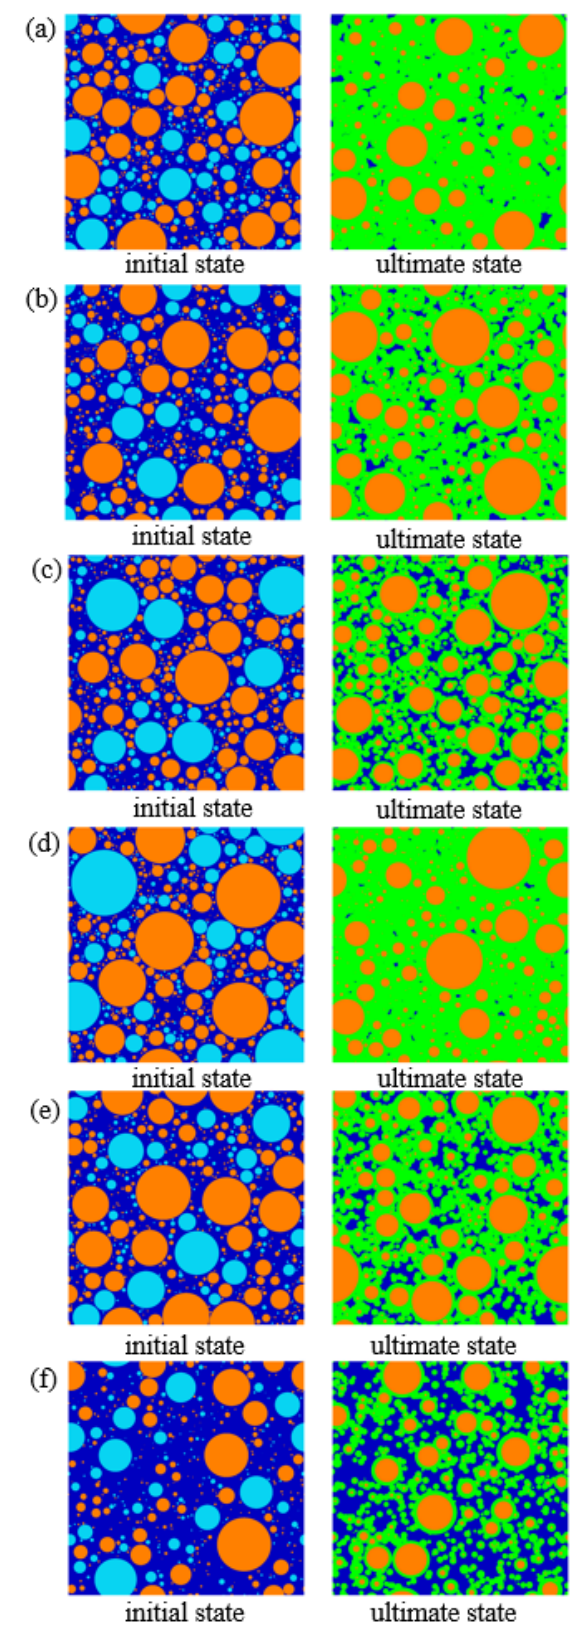
Figure 7. Simulated microstructure of ( a ) MP6H0.25K; ( b ) MP8H0.25K; ( c ) MP10H0.25K; ( d ) MP8H0.2K; ( e ) MP8H0.3K; and ( f ) MP8H0.5K.